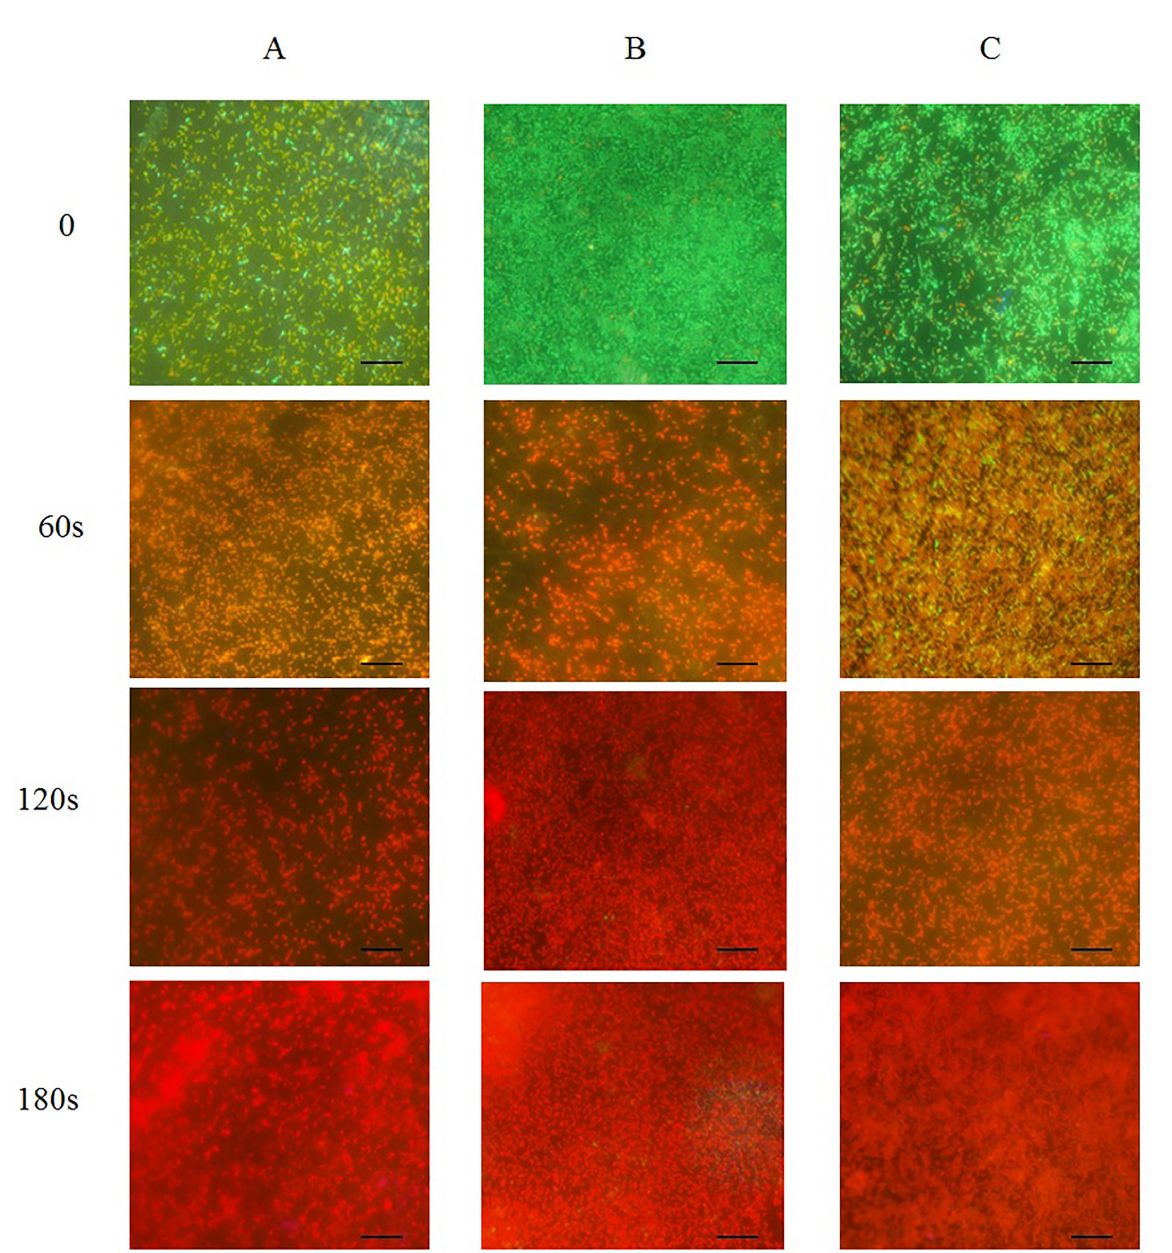
FIGURE 1 - Epifluorescence photomicrographs of biofilms formed by biofilm-producing L. monocytogenes isolates on stainless steel surfaces for 48 hours at 35 ºC, after treatment with peracetic acid (0.5%, v/v) at 60, 120 and 180 s. Isolates A, B and C were classified as serotypes 4b, 1/2b and 1/2b, respectively. Biofilms were stained with bacterial viability kit LIVE/DEAD® BacLight (Molecular Probes, US), in which viable cells are fluorescent green (Syto 9) and non-viable cells are fluorescent red (propidium iodide). Magnification: 1,000x. Bar = 10